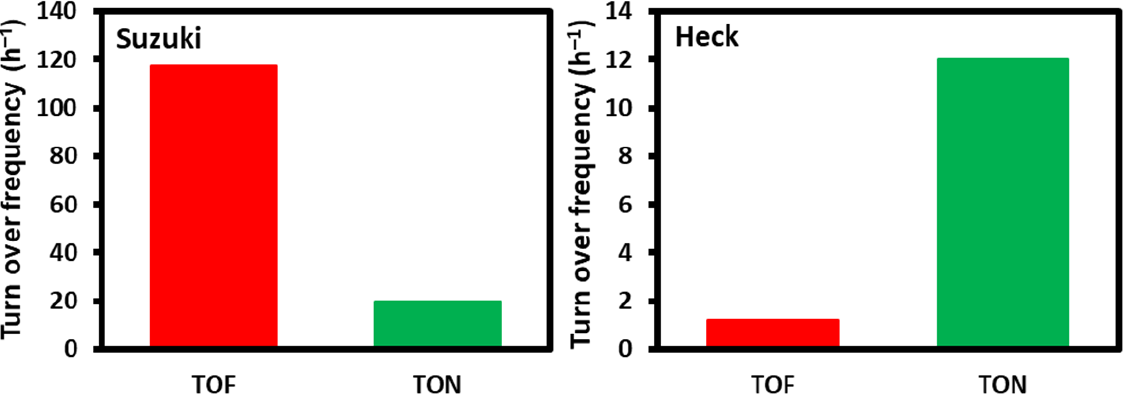
Figure 9. Graphical illustration of the comparative turnover frequency and turnover number (TON) values for the Suzuki and Heck coupling reactions of the 3% Pd/C catalyst.